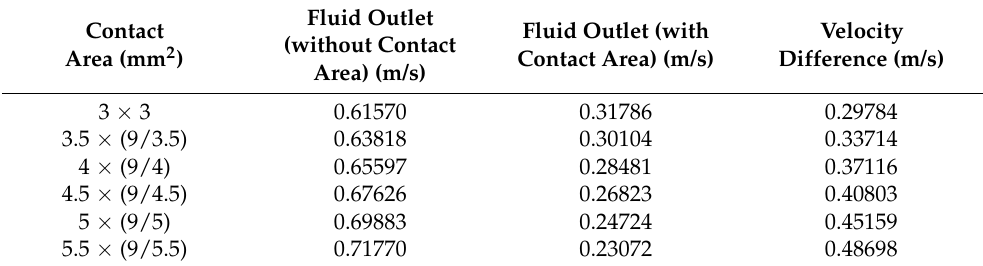
Table 5. Velocity variations in the bifurcated fractures (contact area is 9 mm 2 ).